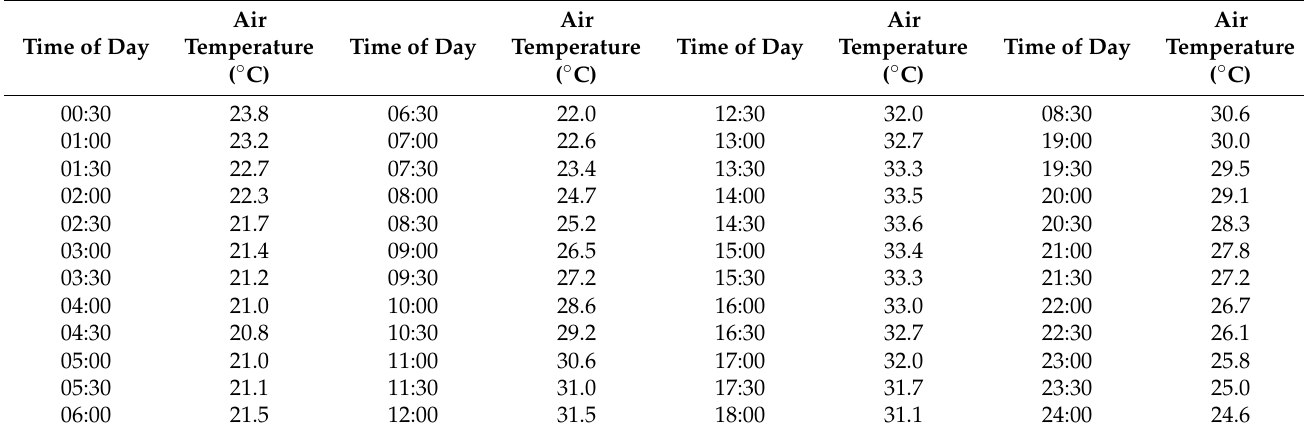
Table 3. Atmospheric temperature during one day in the hot season in Lanzhou.